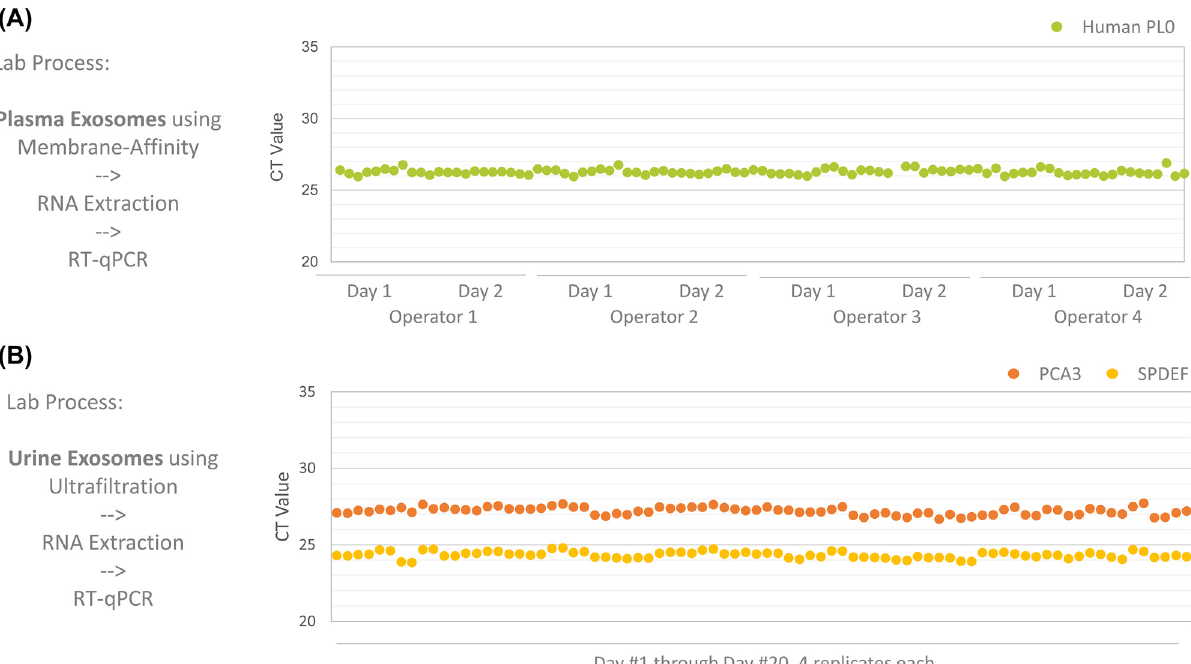
Figure 3: Reproducibility of EV